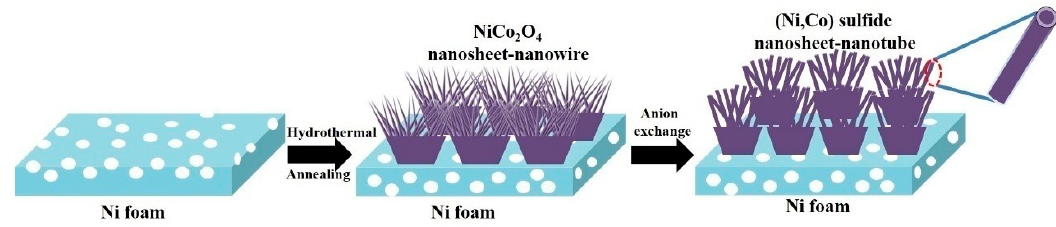
Figure 1. Schematic illustration of the synthesis processes of Ni-Co sulfide nanosheet-nanotube arrays.